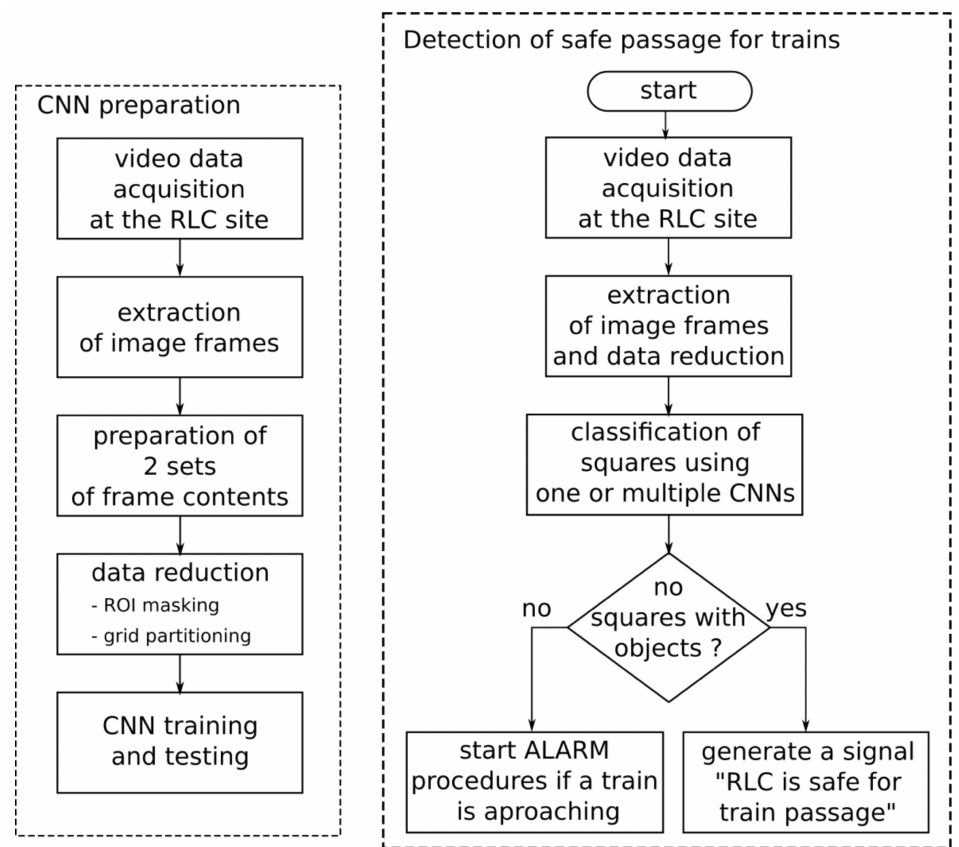
Figure 5. Block diagram of the method for classification of the state of the RLC: ( a ) preparation of the CNN, ( b ) determination of the state of the